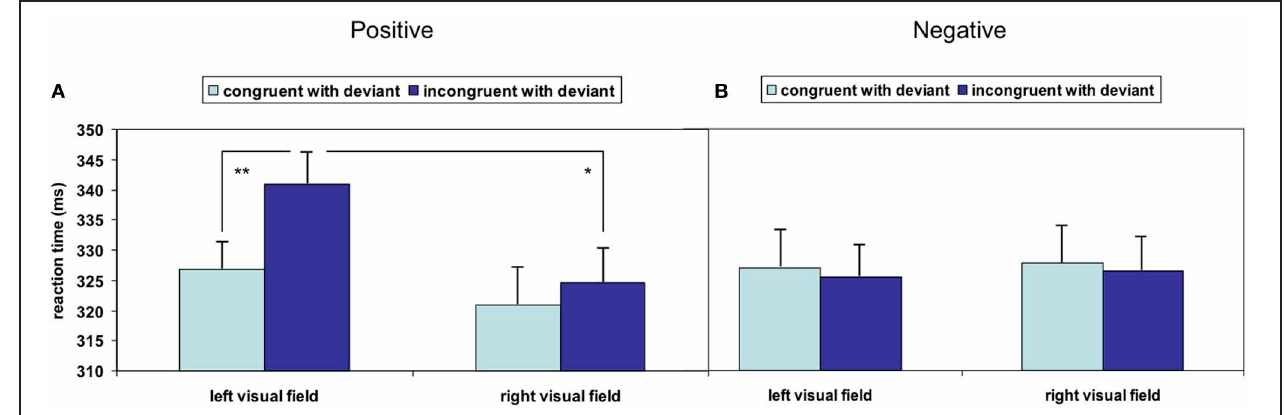
FIGURE 2 | Significant crossmodal interactions of stimulation sides emerged in the (A) positive valence condition but not in the (B) negative valence condition. A congruency effect could be detected in the left visual